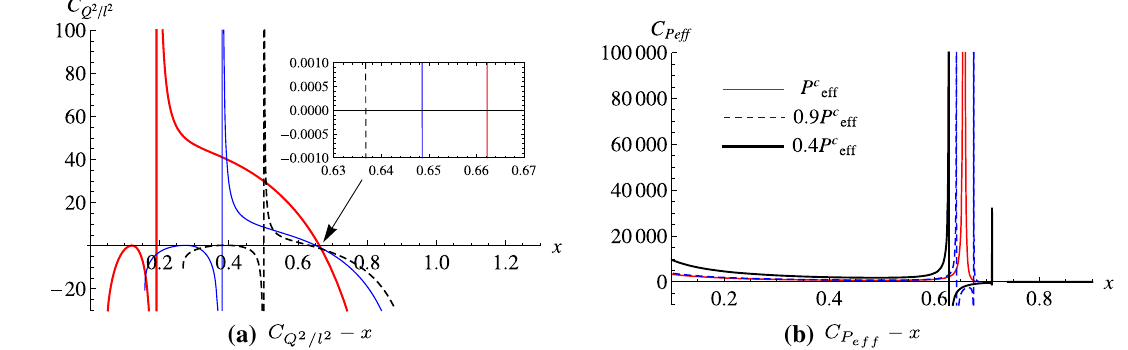
Fig. 4 The pictures of C Q 2 / l 2 and C P